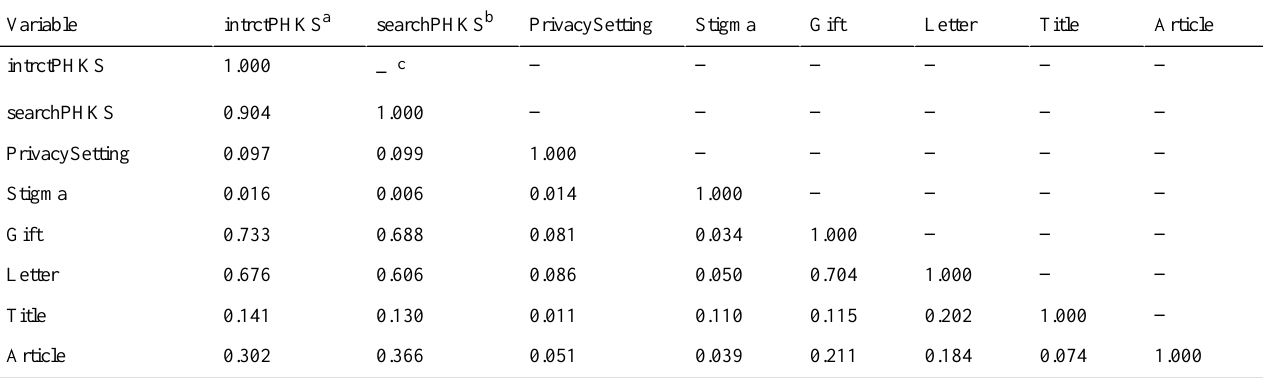
Table 3. Correlation coefficients between independent